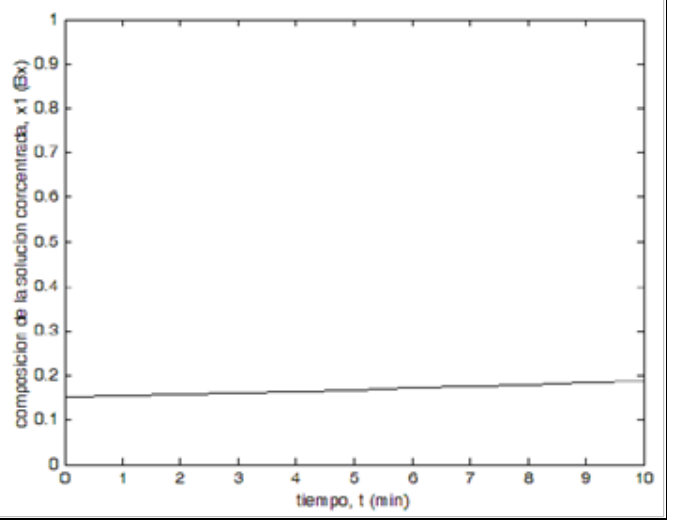
Figura 5: Gráfica composición del líquido en el evaporador contra tiempo de procesamiento. Tabla 1: Modo de operación continuo, variables y parámetros de